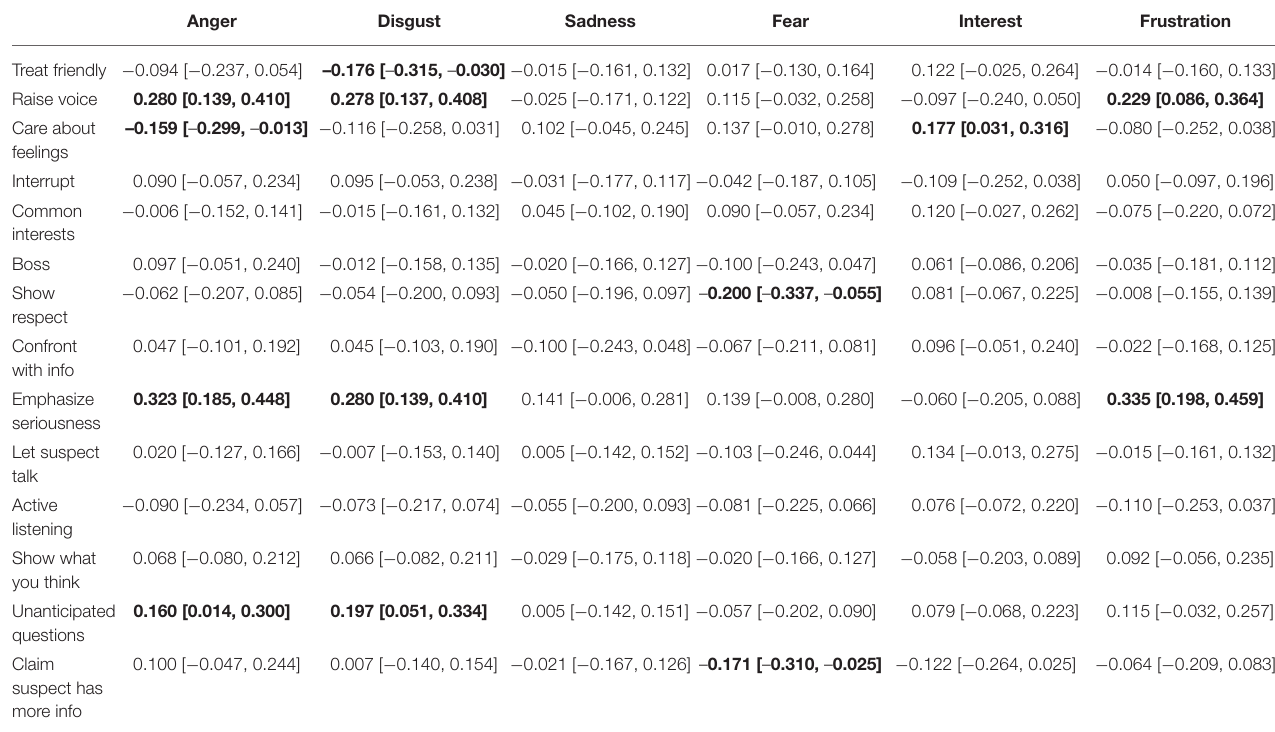
TABLE 7 | Bivariate correlations and 95% confidence intervals of interview tactics and emotion composites. Anger Disgust Sadness Fear Interest Frustration